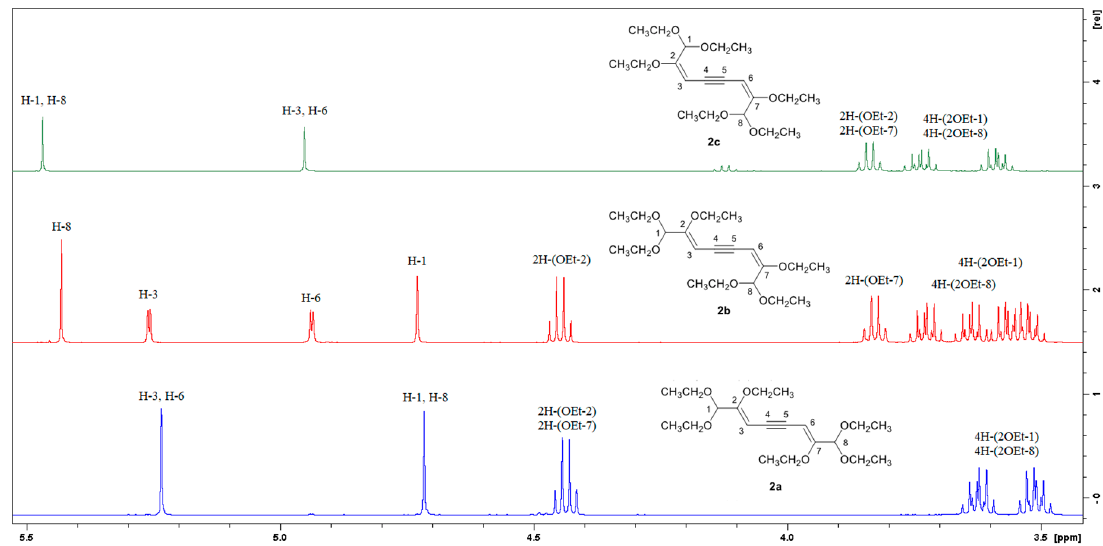
Figure 1. The 5.5 – 3.4 ppm region of the 1 H-NMR spectra of the three isomers of 2 . The signals in the 4.6 – 3.4 ppm region are due to the methylene moieties in the ethoxy groups attached to C-1, C-2, C-7, and C-8. To denote the two hydrogen atoms in the methylene group in EtO attached to C-n, the following notation is used: 2H-(OEt-n).